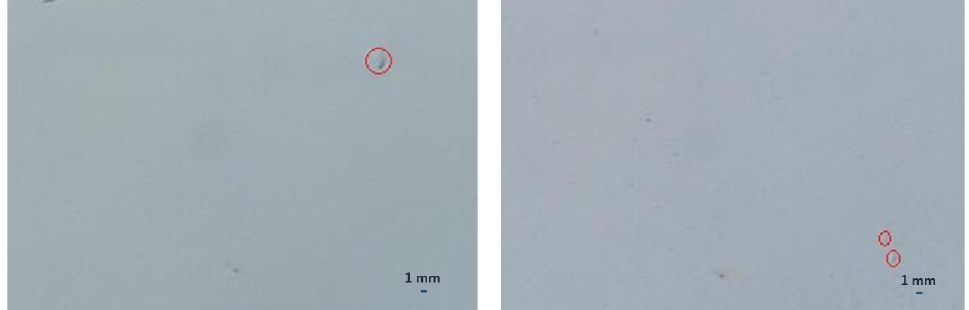
Figure 12. Example images of the reference surface with one water droplet, shown in a red circle.